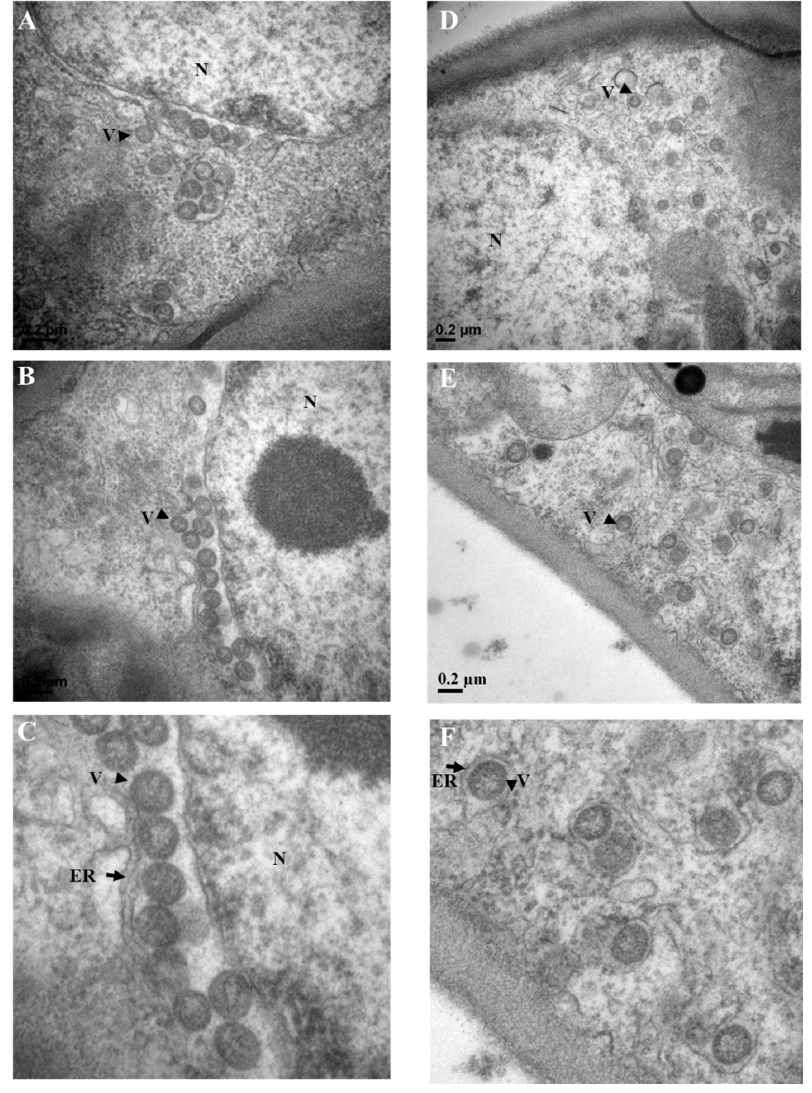
Figure 6. Transmission electron microscopy observation of jujube cells infected by jujube yellow mottle-associated virus (JYMaV). Spherical virus-like particles located between nucleus membrane and endoplasmic reticulum ( A , B ), aggregated in the cavity structure of endoplasmic reticulum ( A ) and individually surrounded by endoplasmic reticulum-like membrane structures in cytoplasm ( C , D ). The enlarged sections of ( B , E ) were shown in ( C , F ). Virus particles were indicated by arrow heads and endoplasmic reticulum-like structures were indicated by arrows. ER: endoplasmic reticulum; N: nucleus; V: virion. Scale bar = 0.2 μ m.